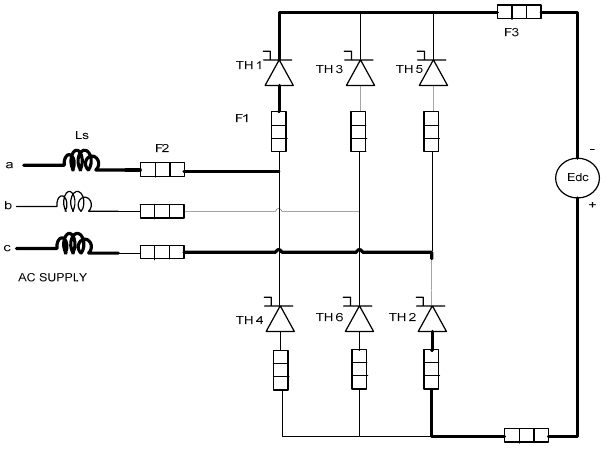
Figure 1. Internal commutation fault regenerative